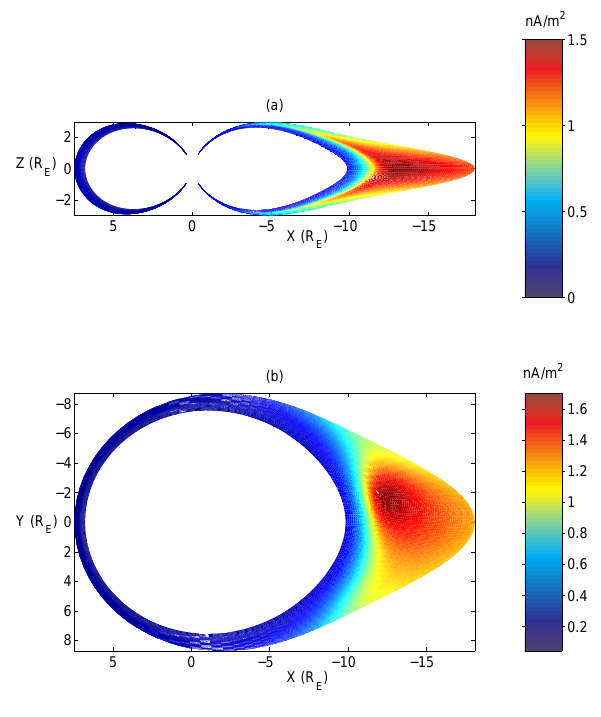
Fig. 8. Azimuthal current density J φ in the (a) noon-midnight and (b) equatorial planes for the equilibrium obtained with GEOTAIL pressure